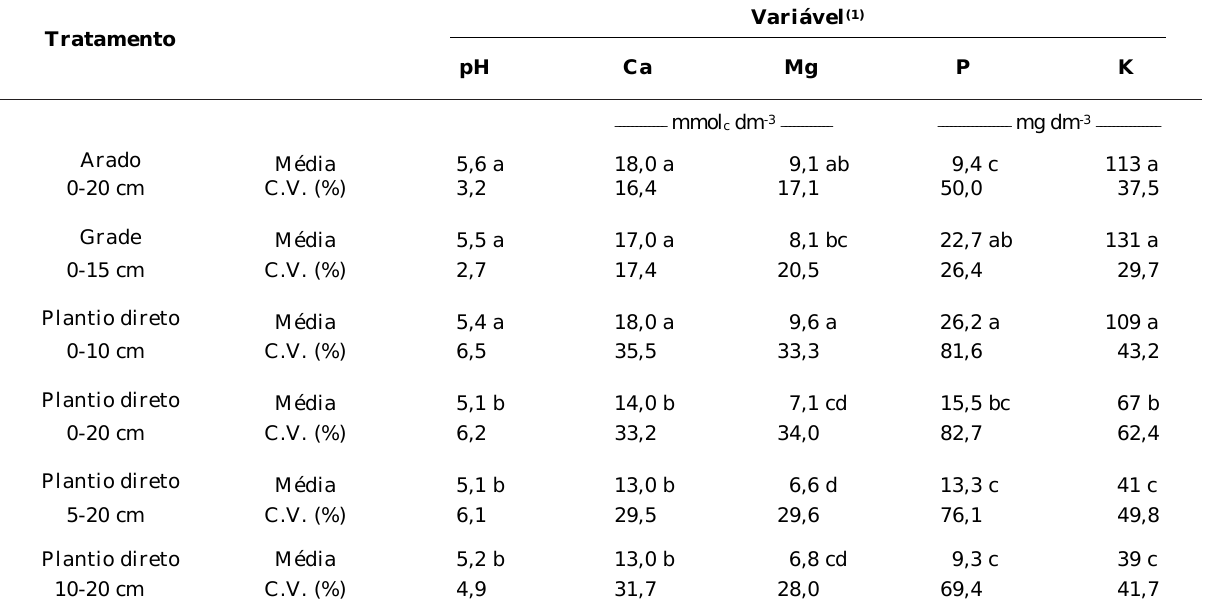
O), Ca, Mg, P e K, 2